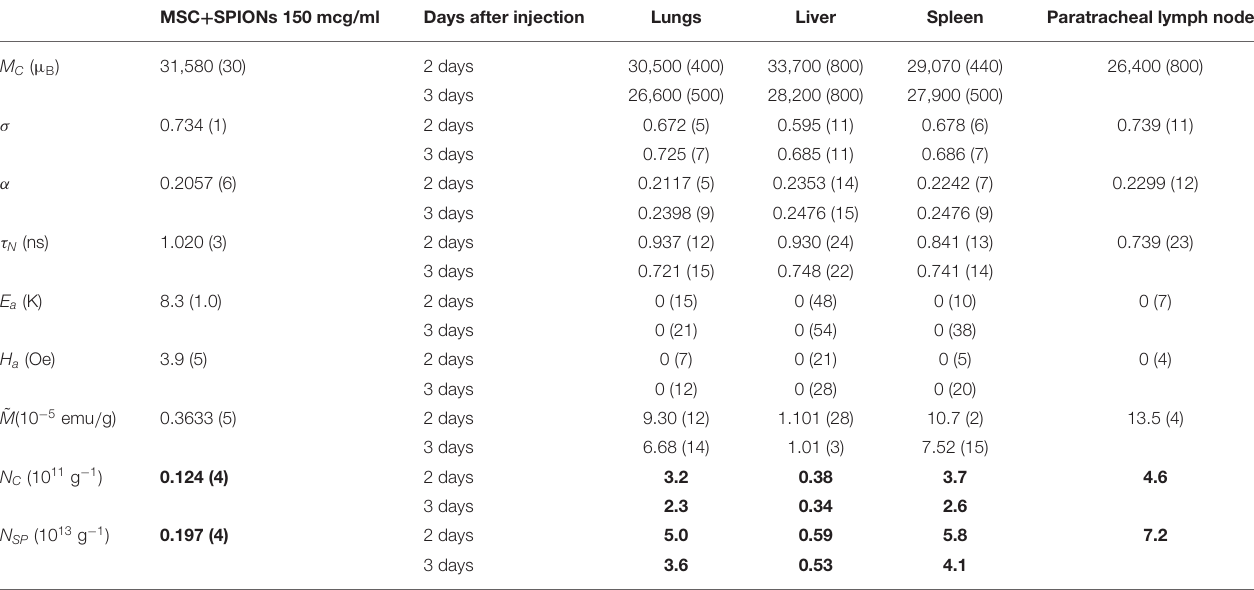
TABLE 1 | Magnetic parameters of injected MSC SPIONs suspension and of rabbit lungs, liver, spleen, and paratracheal lymph nodes: mean magnetic moment M C , + lognormal distribution width of magnetic moments σ , damping constant α , Néel relaxation time τ N , anisotropy energy E a and field H a , saturation magnetization of the sample per gram of tissue ˜ M , and mean concentration of aggregates N C and of SPIONs N SP in tissues,